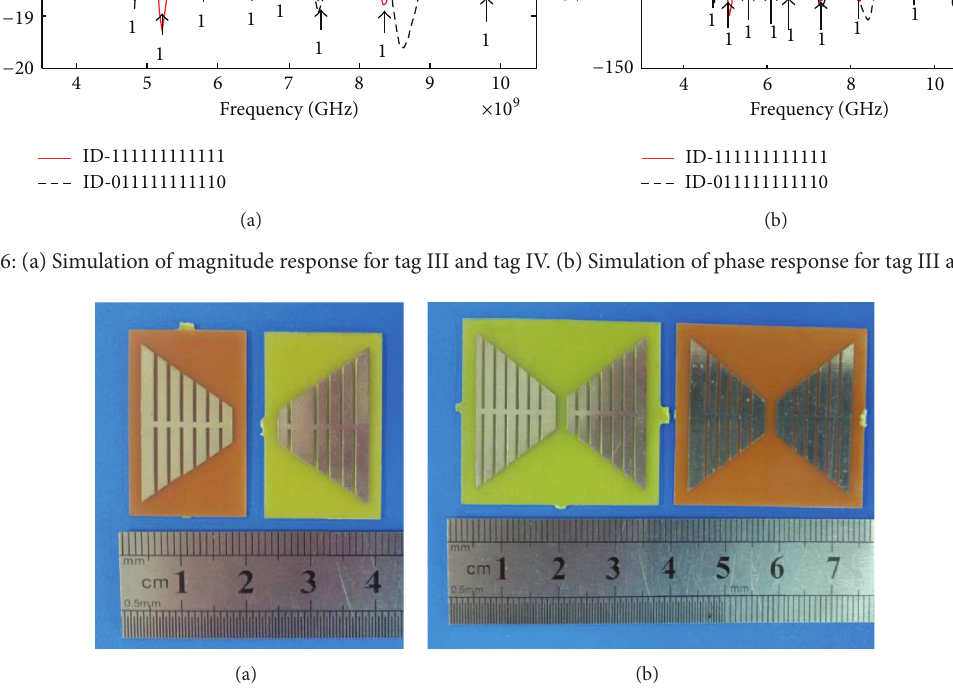
agreement between measurement results and simulation results validates this design of chipless RFID